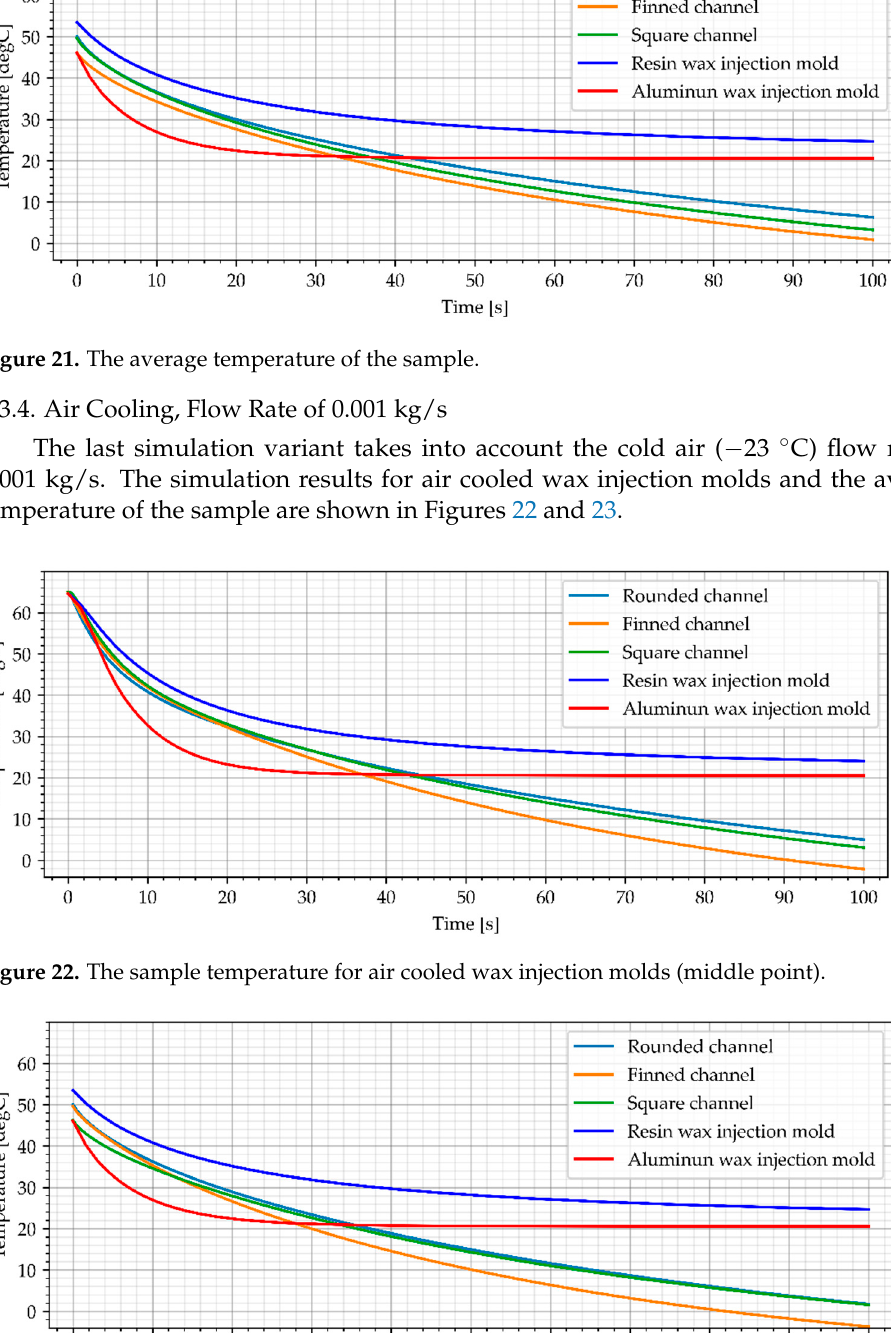
Figure 21. The average temperature of the sample.